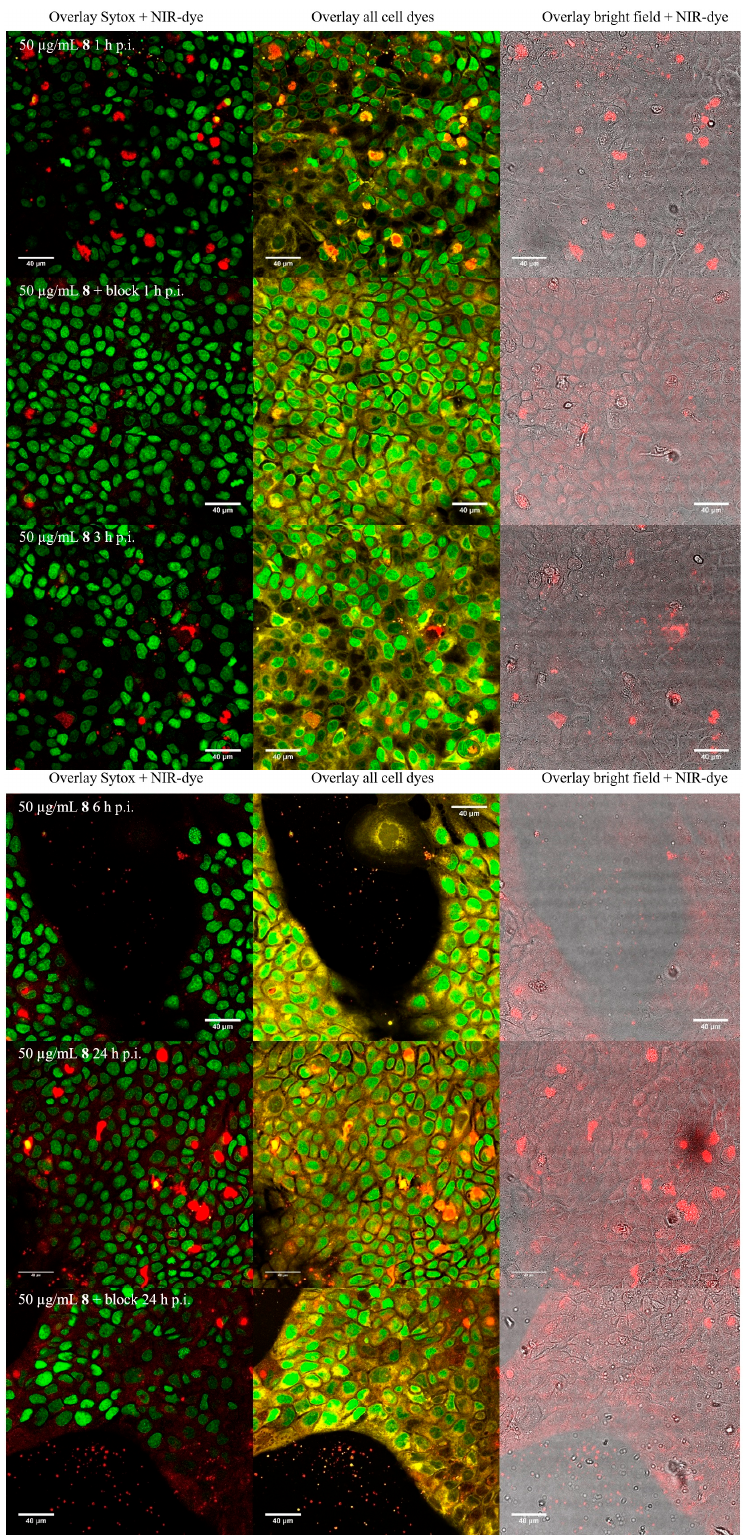
Figure A16. Fluorescence microscopy of A431-cells incubated with AuNP-RGD-NIR-dye 8 at same concentrations (50 μ g/mL) at 1, 3, 6, and 24 h (from top to bottom). Left row overlays of Sytox Green and 8 are shown. Middle row overlays of Sytox, membrane orange and 8 are shown. Right row overlays of bright field and 8 are shown. The cell nuclei were stained with Sytox Green and the cytoplasma with membrane